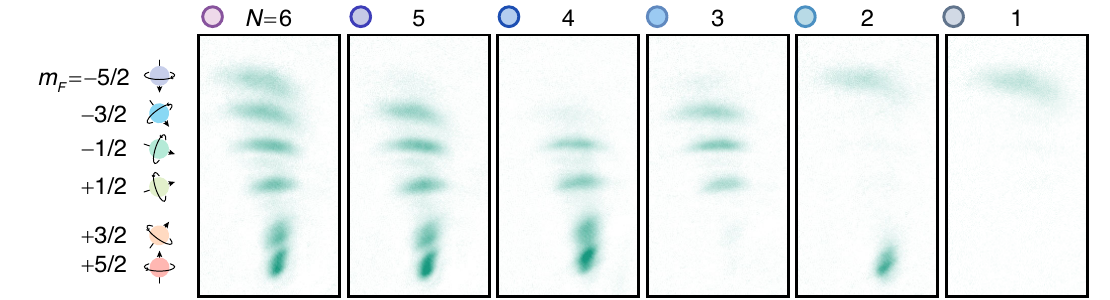
FIG. 5. Fermi gases with tunable spin components. Unwanted spin components are removed by short pulses of resonant σ þ and σ − atomic transitions from 1 S 0 → 1 p 1 in an around 13.6 G magnetic field. From left to right, the number of spin states is prepared from N ¼ 6 to N ¼ 1 . Optical Stern-Gerlach detection is used to monitor the spin configurations, and split subclouds from top to bottom are m ¼ − 5 = 2 to m ¼ 5 = 2 . F F